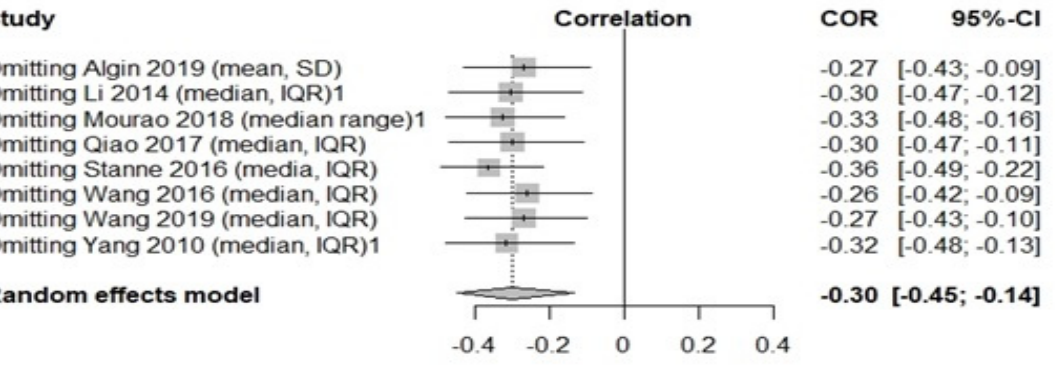
Figure 4. Sensitivity analysis serum BDNF and